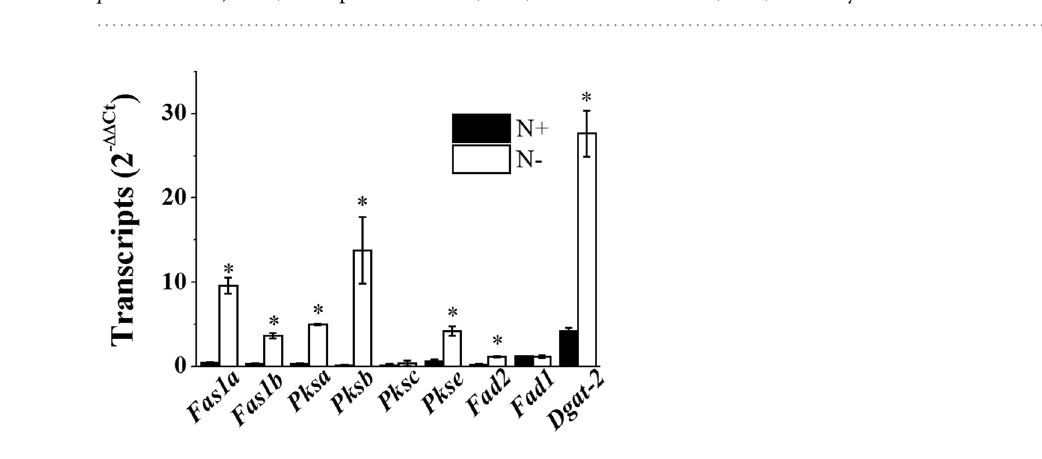
Figure 2. Transcript levels of cytosolic fatty acid and lipid biosynthesis genes in N. salina cells grown under N + and N − conditions for 2 days. Each data point represents the mean ± SE of three biological and technical triplicate culture